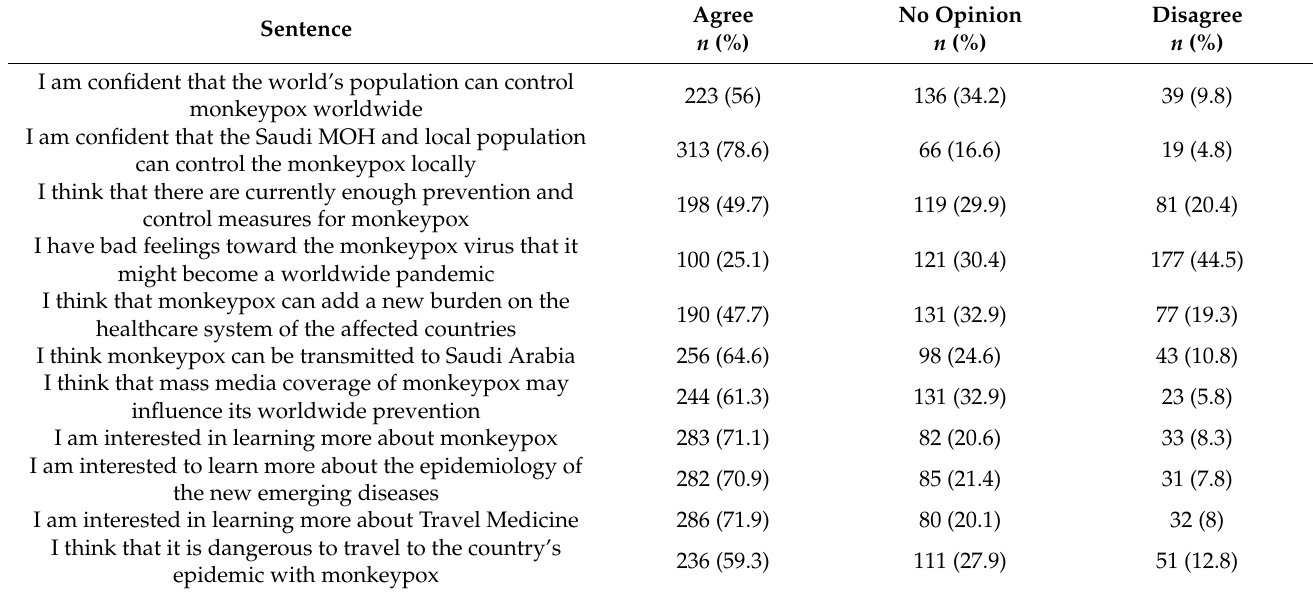
Table 5. Attitudes about monkeypox virus, emerging diseases and travel epidemiology among Saudi physicians who participated in the study ( n =